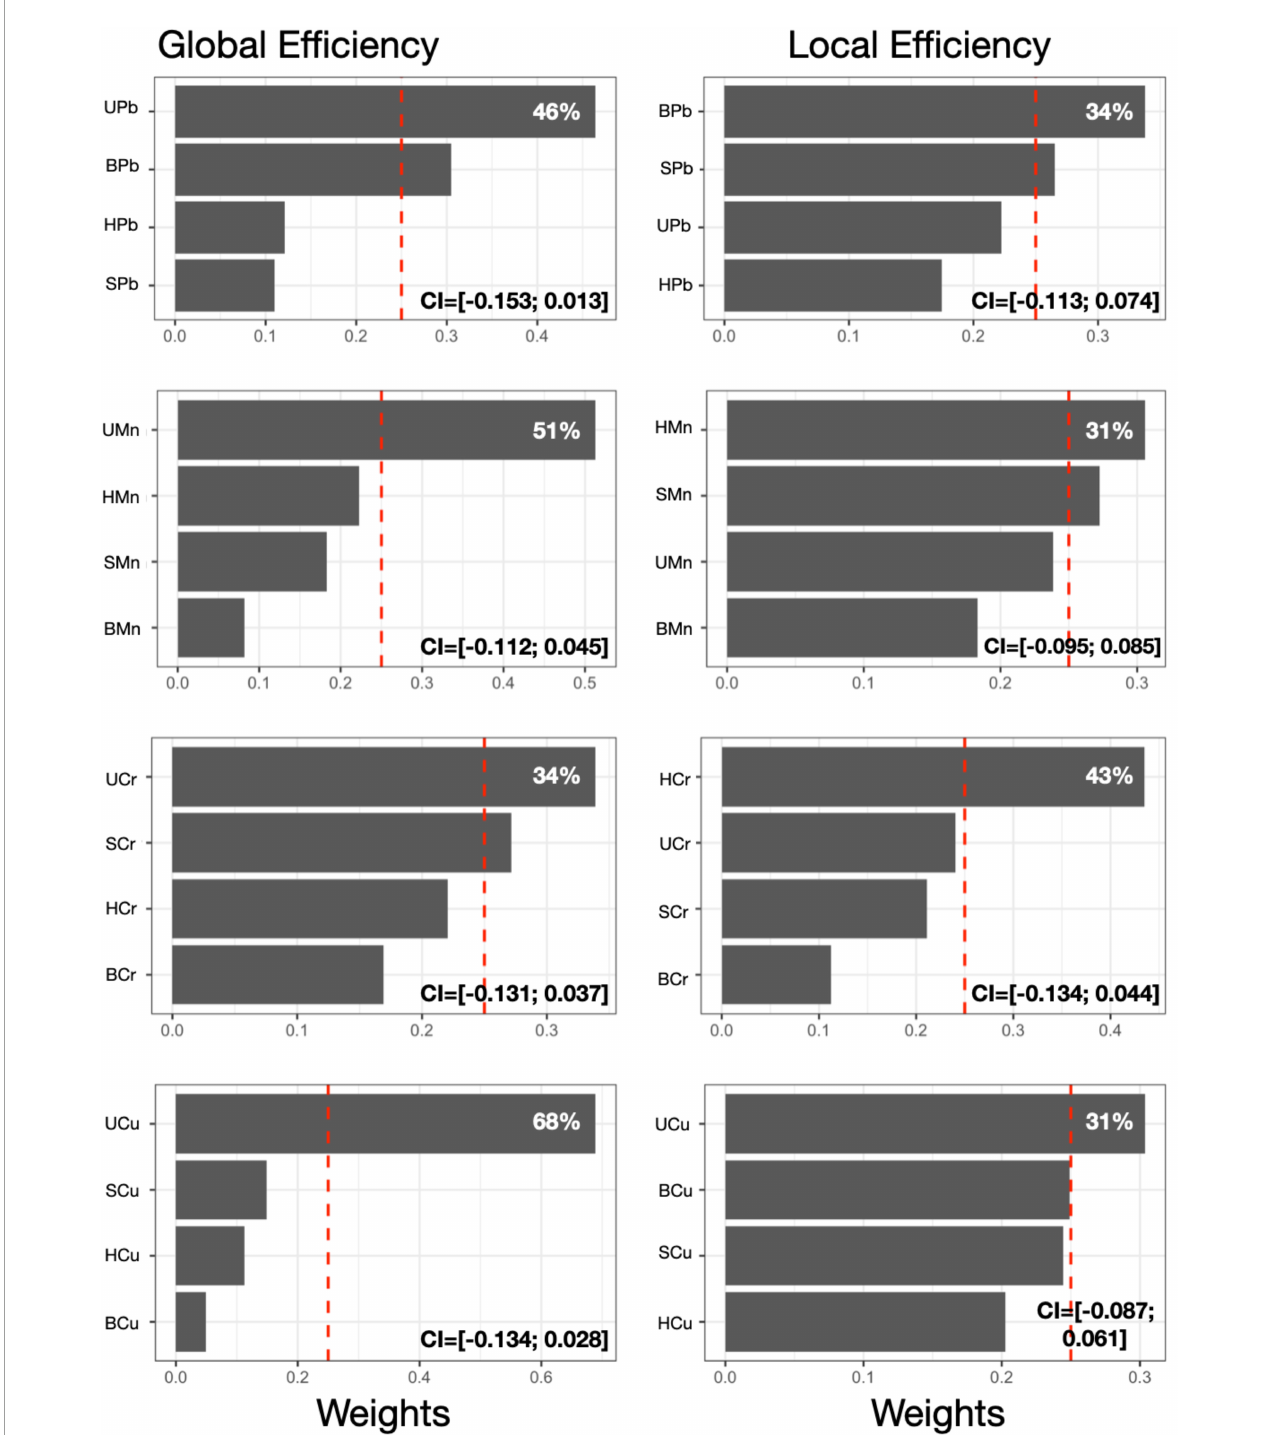
FIGURE2 First level MMB models. Results obtained from the MMB WQS association between each metal’s respective exposure biomarker (e.g., blood Pb) and GE or LE was estimated among 193 adolescents included in the current study. Bar plots show estimated weights for each component of the mixture in the WQS regressions. Red dotted lines represent the significant thresholds for each WQS model. 95% confidence intervals obtained for each individual MMB WQS model are reported. All models were adjusted for sex and age. Components abbreviations: the first letter represents the medium (S, saliva; B, blood; U, urine; H, hair) and the second and third letters represent the metals (Mn, manganese; Pb, lead; Cr, chromium; Cu,